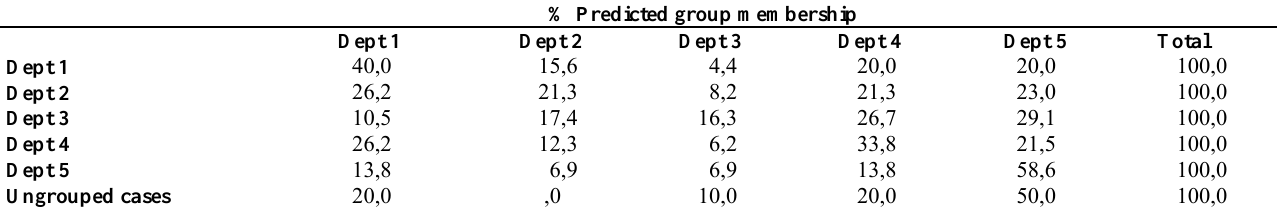
Table 4: Differences between groups (Stepwise Discriminant